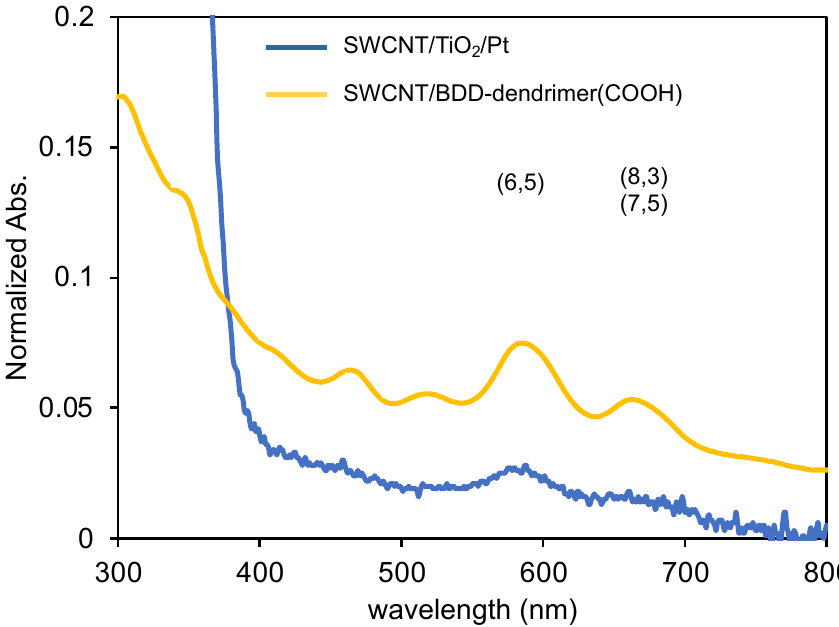
Figure 3. Absorption spectra of SWCNT/TiO 2 /Pt (blue line) and SWCNT/BDD-dendrimer(COOH) nanohybrids (orange line).